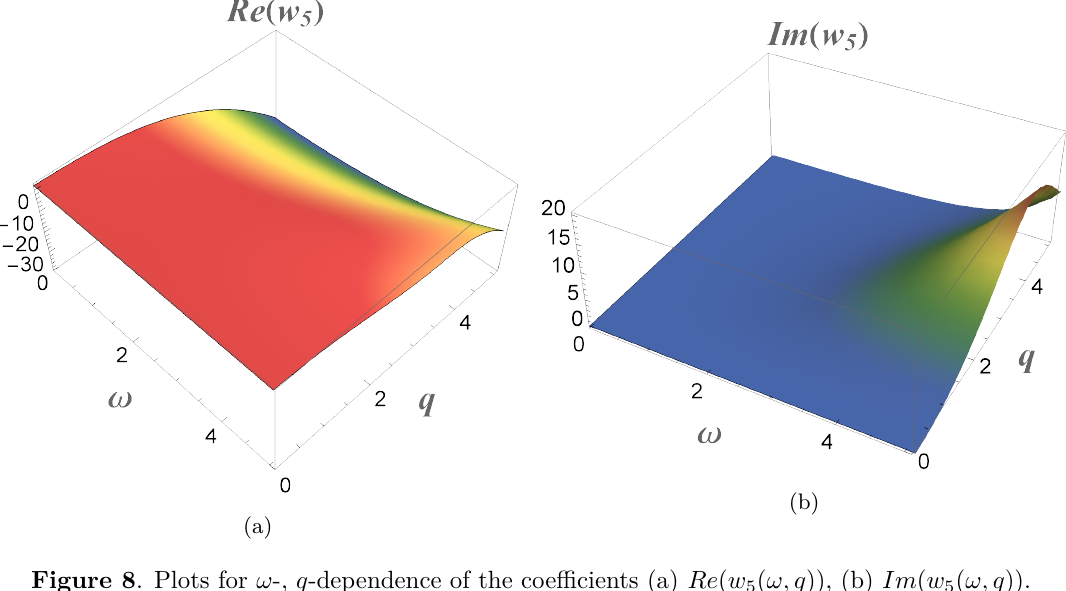
Figure 8 . Plots for ω -, q -dependence of the coefficients (a) Re ( w 5 ( ω, q )) , (b) Im ( w 5 ( ω, q )) .